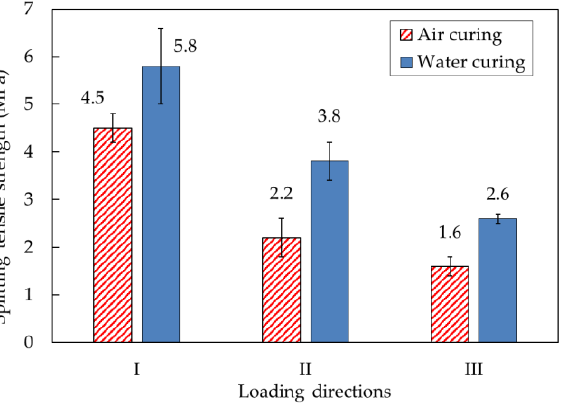
Figure 16. Splitting tensile strength tests under three loading directions. ( a ) Loading direction I; ( b ) Loading direction II; ( c ) Loading direction III.